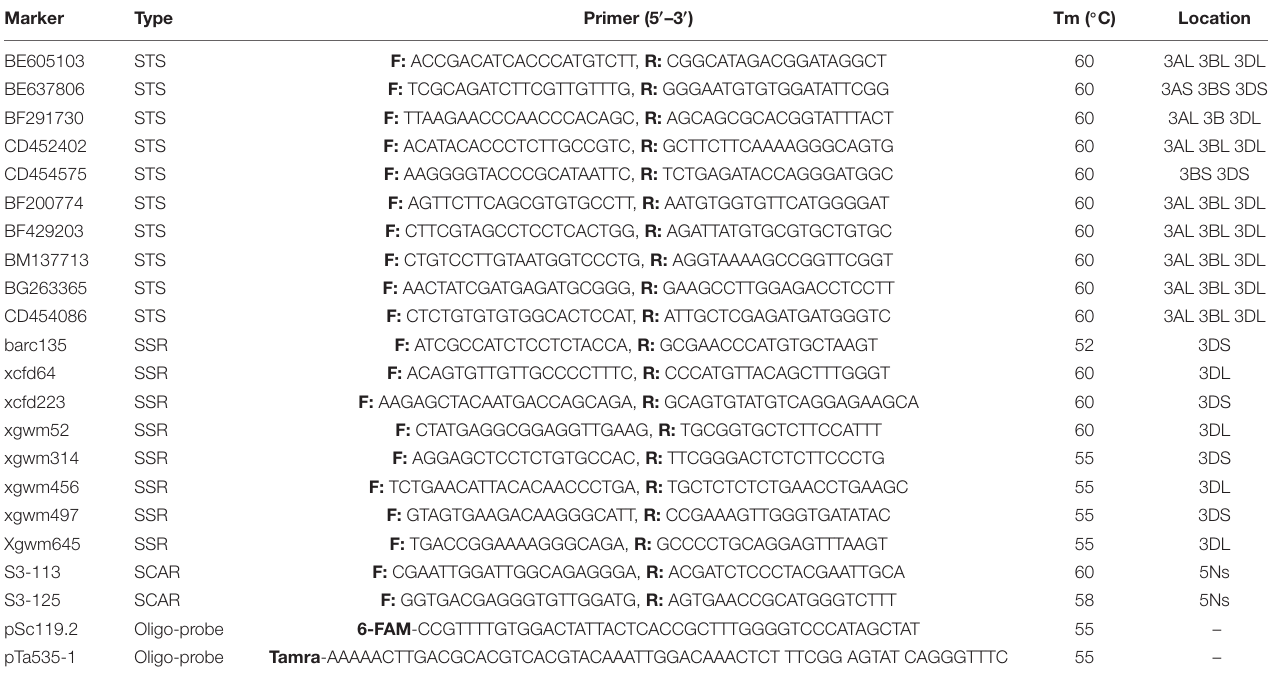
TABLE 1 | Molecular markers and FISH oligo-primers used in this study to analyze the chromosomal composition of DH109 and DM131.